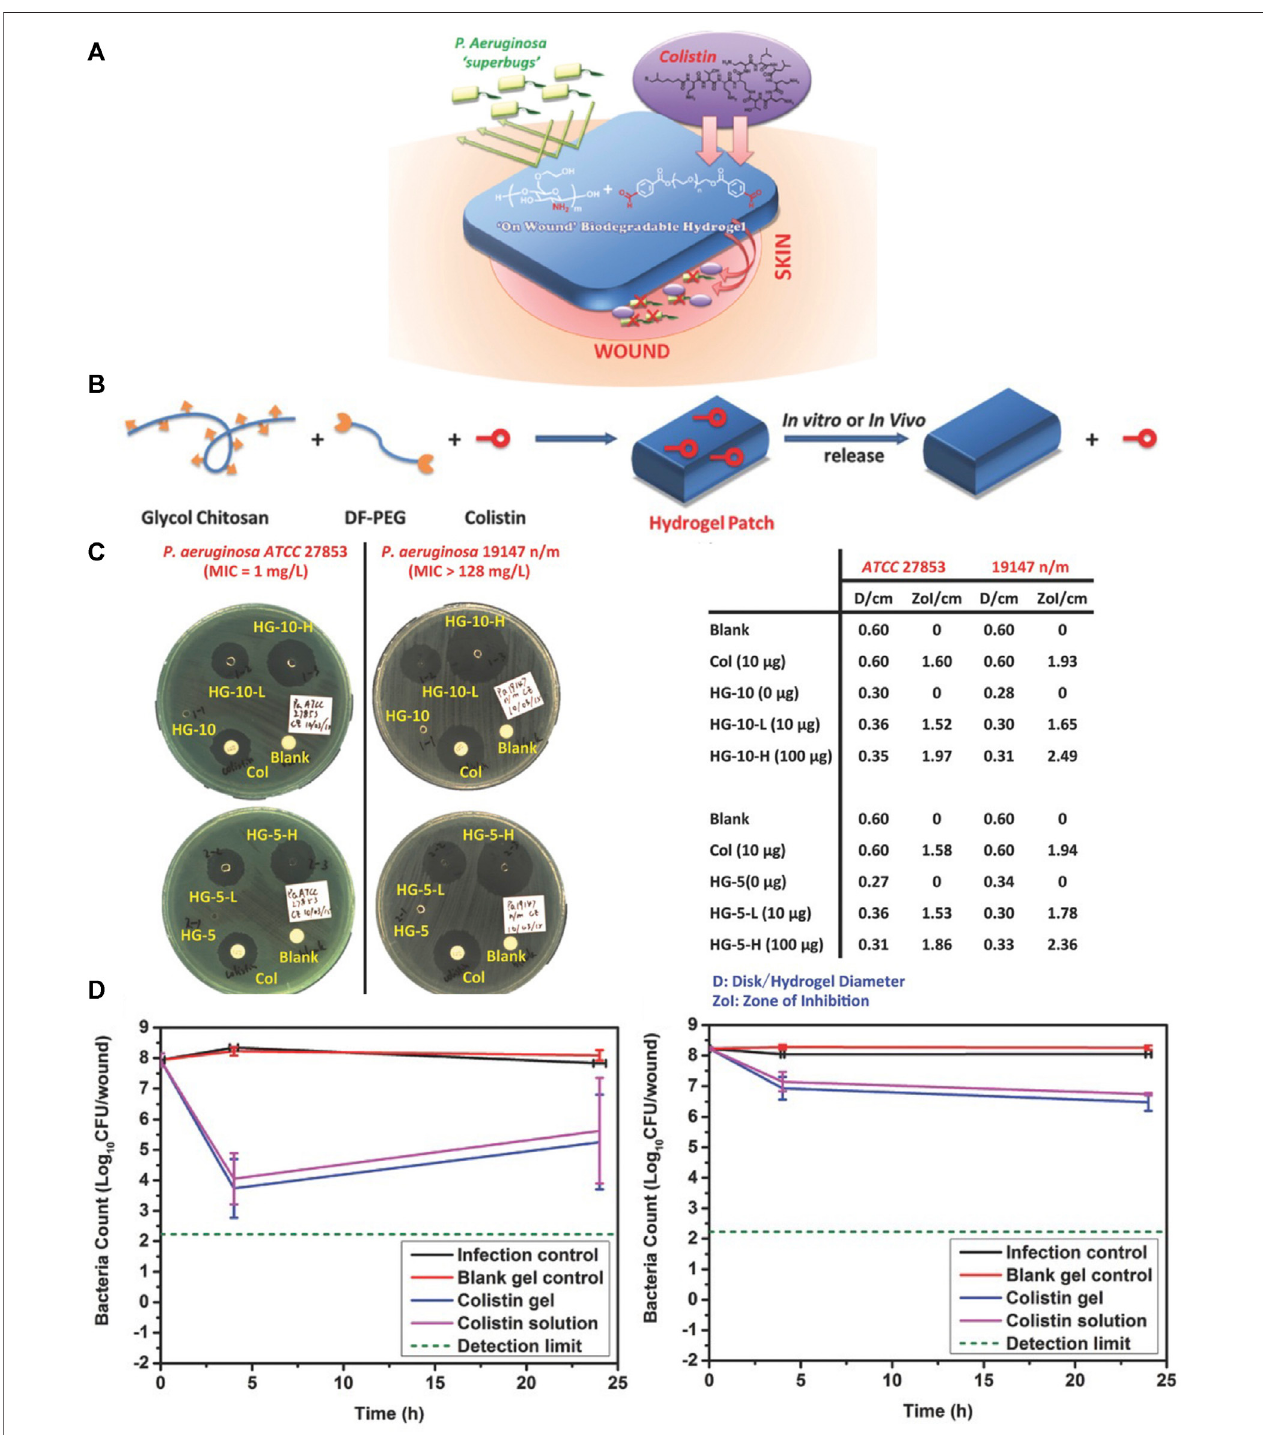
FIGURE 5 | Hydrogel-based localized release of colistin for antimicrobial treatment of infections from burn wounds. (A) Treatment of a burn wound with a colistin- loaded hydrogel (schematic). (B) Synthesis of a colistin-containing hydrogel (schematic). (C) Disk diffusion assay of a colistin-loaded hydrogel against colistin-sensitive (left) and colistin-resistant (right) P. aeruginosa strains (D) Test of colistin-loaded hydrogel against colistin-sensitive (left) and colistin-resistant (right) strains of P. aeruginosa in a model of burn infection. Reproduced with permission from (Zhu et al., 2017).